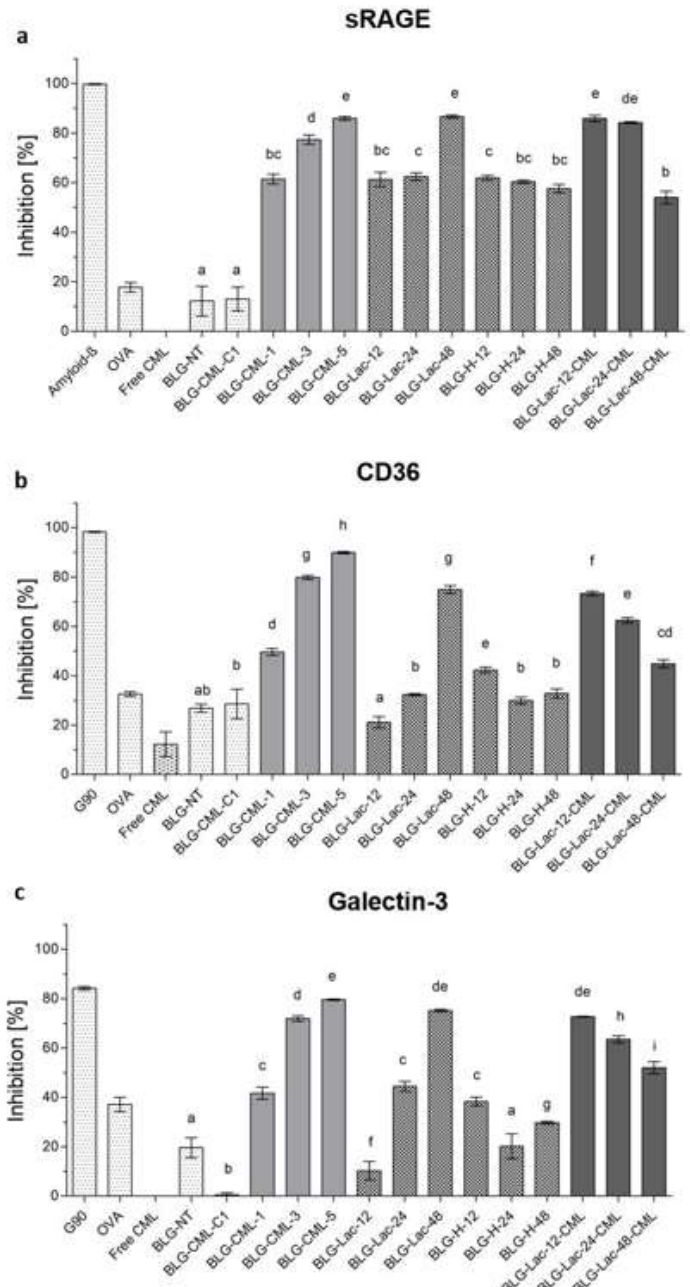
Figure 5. Inhibition ELISA for binding of ( a ) sRAGE, ( b ) CD36, and ( c ) Galectin-3 to β-lactoglobulin (BLG), non-treated (NT), control for chemical modification (CML-C1), chemically modified BLG with N ɛ -carboxymethyl lysine (CML) at different levels of CML, glycated with lactose (Lac) by heating at 60 °C for 12, 24, and 48 hours; heated at 60 °C for 12, 24, and 48 hours in the absence of any sugars (H), and glycated by heating with lactose followed by CML induction with glyoxal , with ovalbumin (OVA) as negative control, and glycated soy protein (G90) as positive control for CD36 and galectin-3, as well as amyloid-β as positive control for sRAGE. Protein concentrations were set to 100 µg/mL, while free CML was used at 2 mg/mL. Significant differences were tested using one-way ANOVA with Tukey post-hoc test, considered as significant at p < 0.05 between technical replicates ( n = 3), where two variables have different letters if they are significantly different.